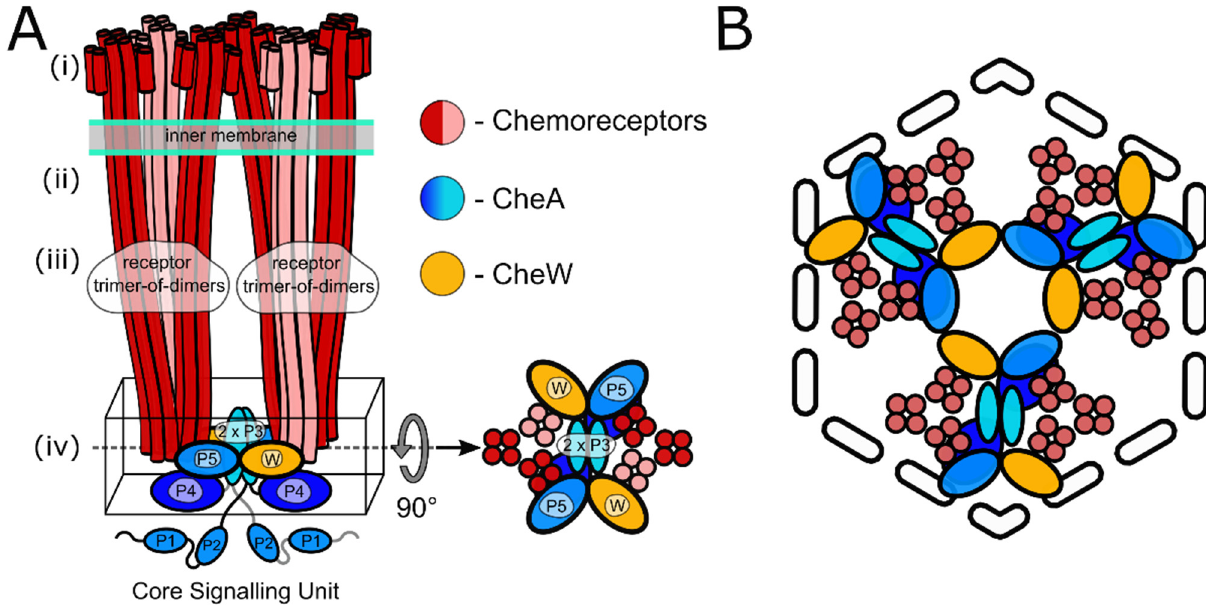
Figure 1. Schematics of the core signalling unit and organisation of three CSUs into a hexagon. ( A ) Two ToDs interact with CheA and CheW to form a CSU shown from the side. In each ToD, two MCP dimers are shown in red and one in salmon for perspective. CheA is shown in shades of blue, and CheW in gold. Domains of CheA are labelled. The baseplate region is boxed and also shown from the top. ( B ) Three CSUs assemble into a hexagon that gives rise to a (A.P5/W) 3 ring characteristic of the pseudo-p6-symmetric array architecture (see also Figure 3B for the extended array organisation showing the formation of (W) 6 rings).